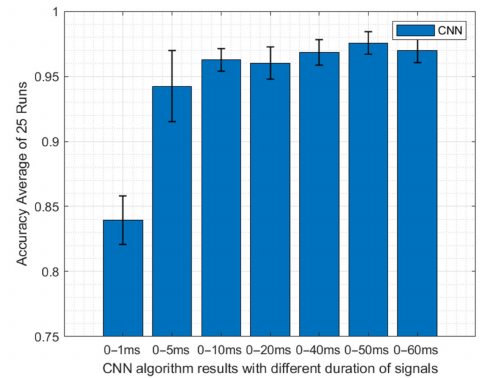
Figure 10. Accuracy and standard deviation results of CNN algorithm with the different time window of the data. The results showed that the highest accuracy with the lowest variation was achieved by using the 0–50 ms portion of the